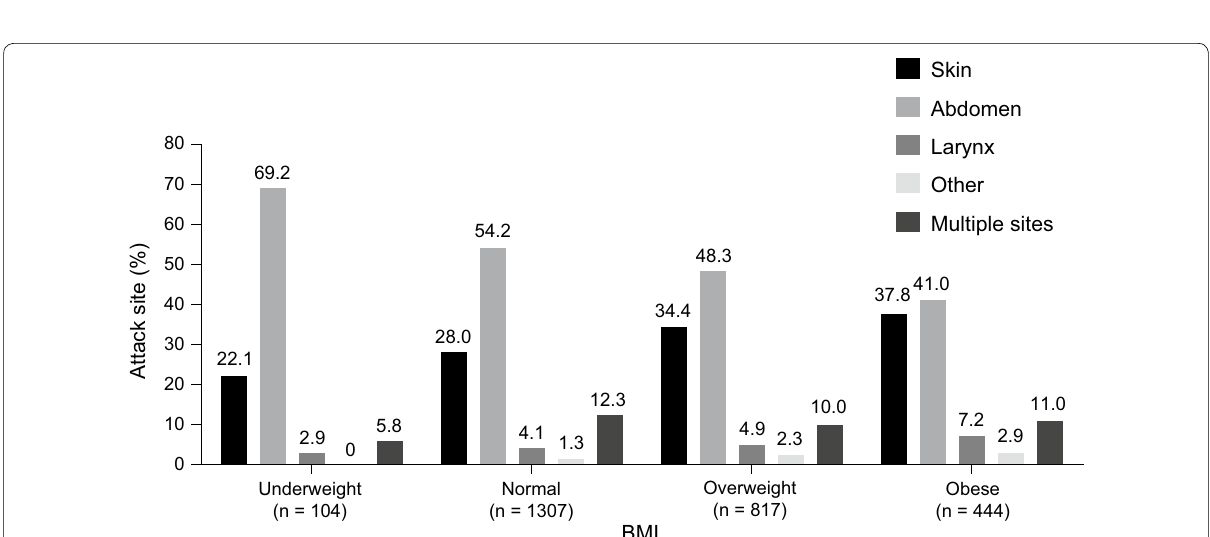
Fig. 2 Site of icatibant-treated attacks by body mass index (BMI). P values comparing frequency of attacks between patients with normal/over- weight/obese BMI: P 0.020 for skin attacks; P 0.003 for abdominal attacks; P 0.282 for laryngeal attacks; P 0.108 for attacks affecting other = = = = organs. Results excluding data from the two reinjection outliers are presented in Additional file 1: Figure S2.